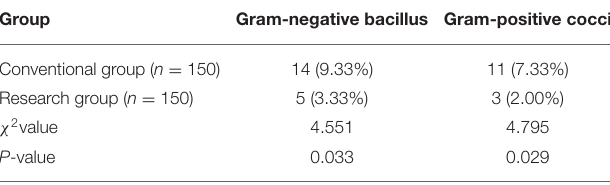
TABLE 2 | Detection of pathogenic bacteria in the two groups ( n , %).